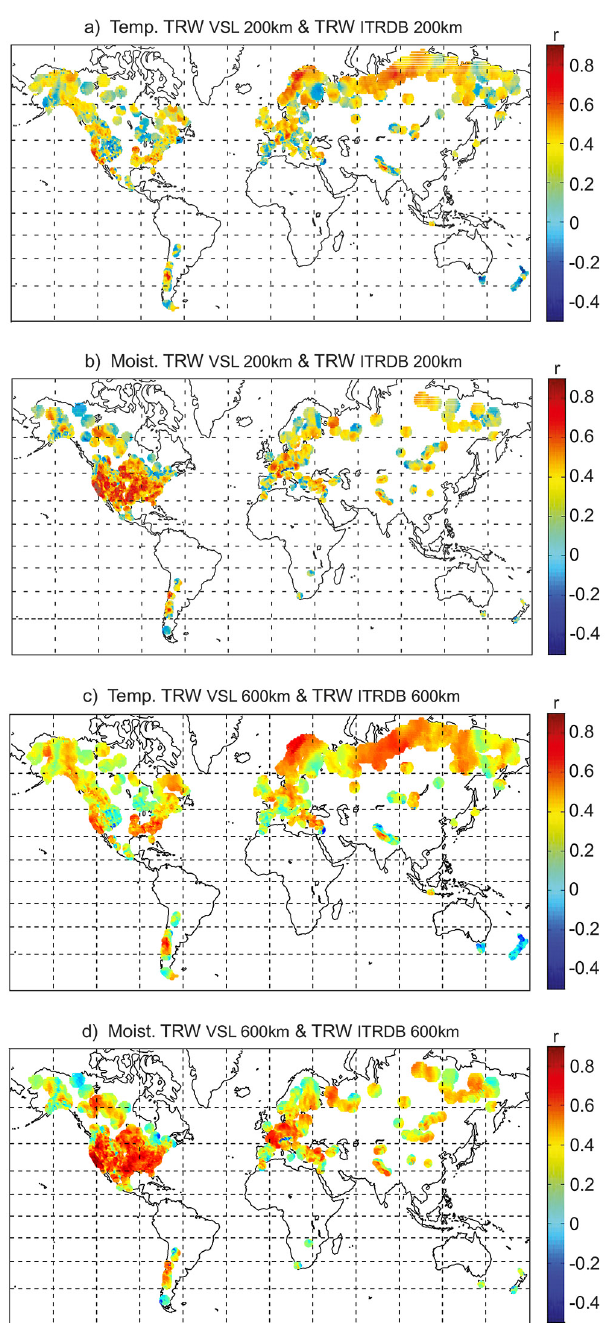
Fig. 5. World map displaying Pearson’s correlation coefficients be- tween ATRW VSL and ATRW ITRDB for a search radius of 200km (a, b) and 600km (c, d) at temperature-limited (a, c) and moisture- limited (b, d) grid cells. Note that in panels (c) and (d) at least one chronology has to be within the 200km search radius to make the correlations